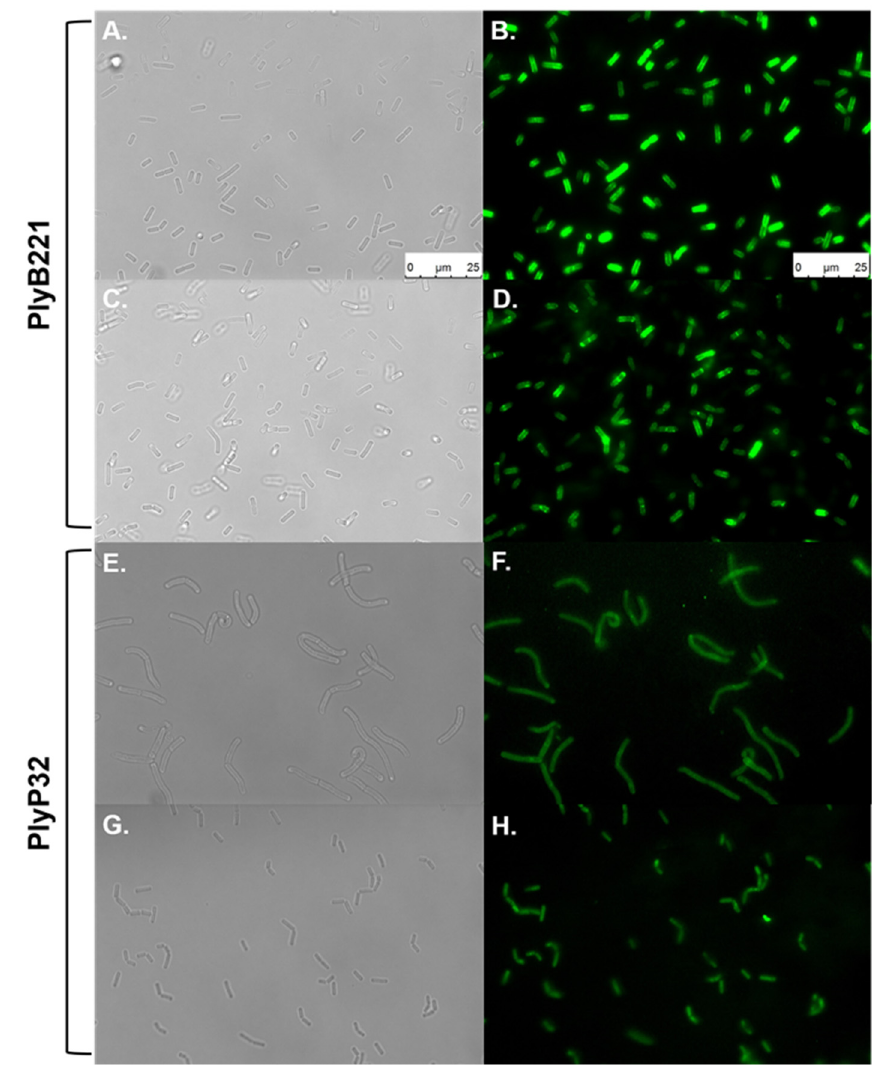
Figure 8. Binding ability of PlyB221 and PlyP32 CBD. Exponentially growing cultures were used in a cell wall decoration assay based on the observation of the GFP fused CBD adsorbed to bacteria by fluorescent microscopy. Images on the left show bright field microscopy while images on the right display the corresponding fluorescent images. ( A , B ) B. cereus ATCC 10,987 - PlyB221_CBD; ( C , D ). B. weihenstephanensis Si0239 - PlyB221_CBD; ( E , F ) B. megaterium Si0003 - PlyP32_CBD; ( G , H ) B. weihenstephanensi s LH002 - PlyP32_CBD. Scale bar = 25 µm for all panels.